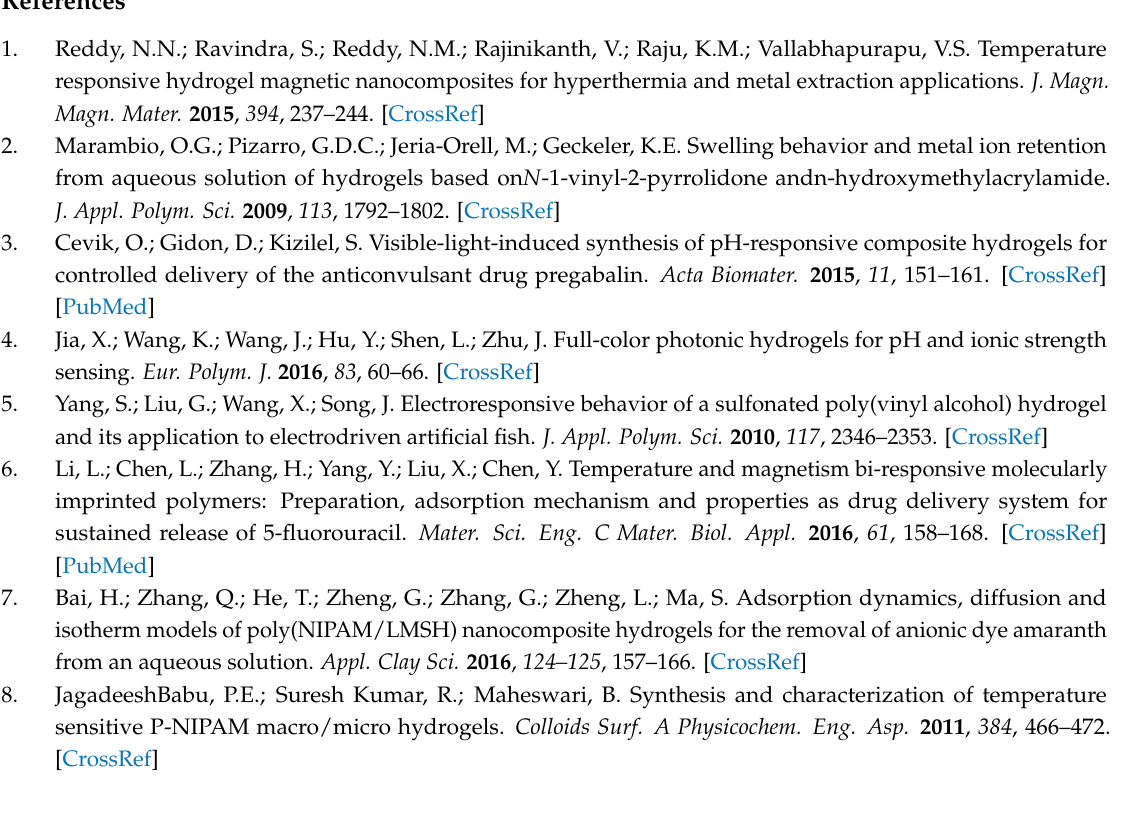
Figure S1: The pore size distribution of PNIPAM-MAPOSS hybrid hydrogels: (a) Gel 6, (b) Gel 7, (c) Gel 3, and (d) Gel 8; Table S1: The cumulative release percentage (%) of Gel 1, Gel 3, Gel 5, Gel 6, and Gel